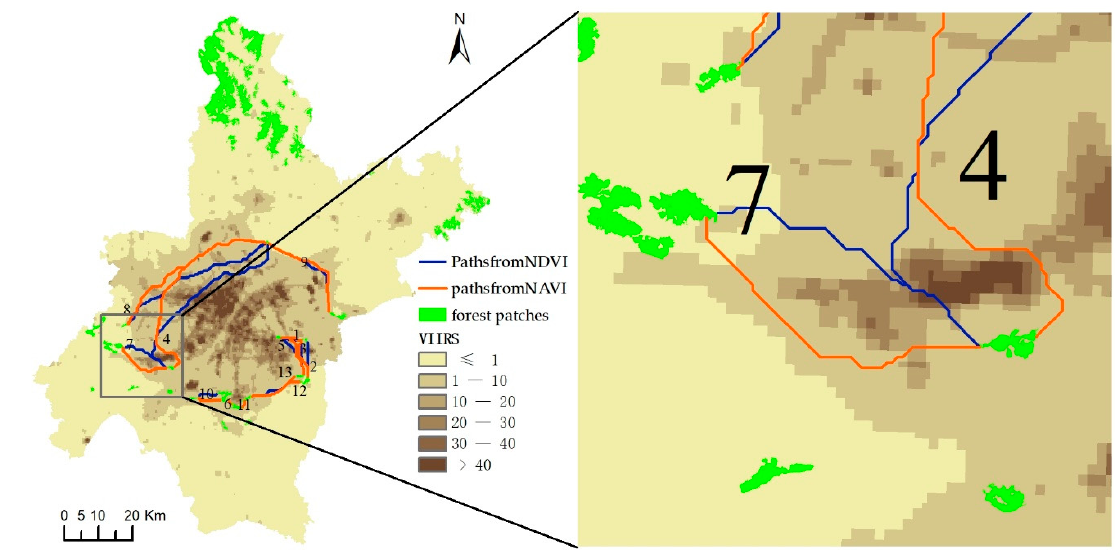
Figure 6. Differences of paths between RNDVI and RNAVI.